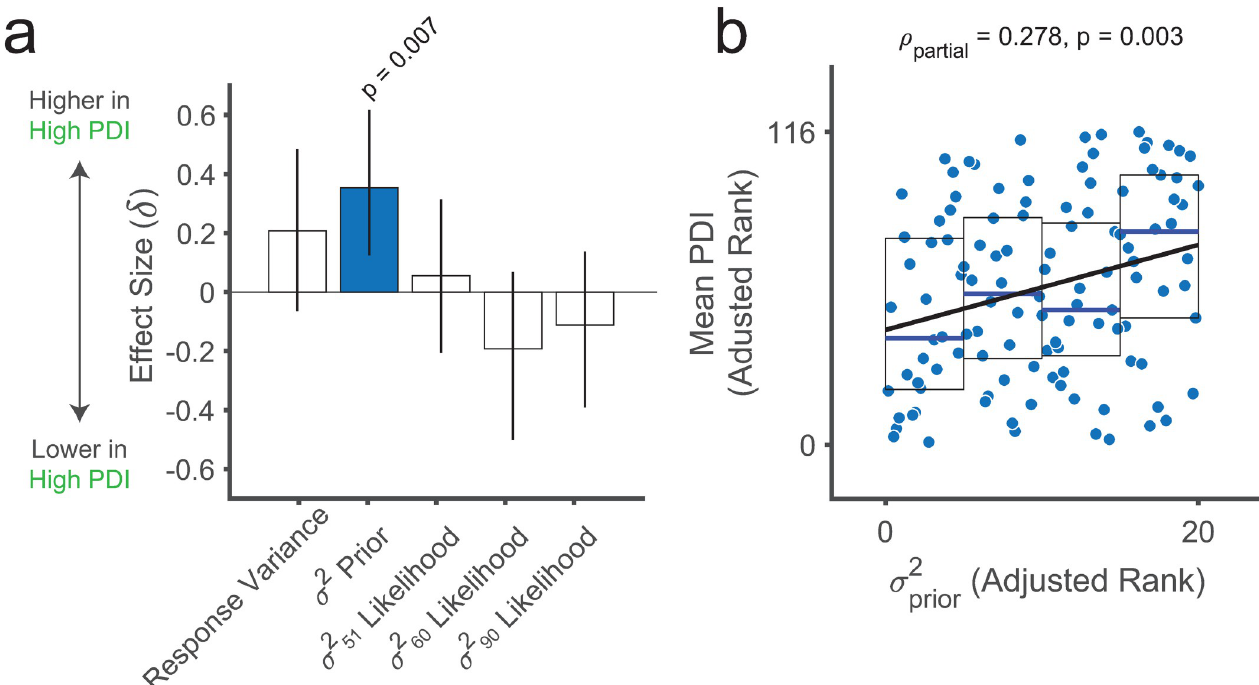
Fig 7. Prior noise relates to belief oddity outside the laboratory. (a) Summary of group-level differences for noisy-sampling model-based and model- agnostic measures between the low (n = 57) and high (n = 34) PDI groups. Bar plots are effect size (Cliff’s delta, δ ) and 95% confidence intervals. (b) Scatterplot showing a positive correlation between ranked mean PDI scores and s 2 (n = 116). Values are adjusted by o parameter values and the model fit (RMSE) for 2 ð l Þ prior specificity as in the partial Spearman correlation analysis. Boxplots show medians (blue lines) and 25 th and 75 th percentiles (bottom and top edges, respectively). The solid black line reflects the least-squares linear fit to the data points. Mean PDI is the average of the global PDI scores across the pre-screening and the experimental sessions for each